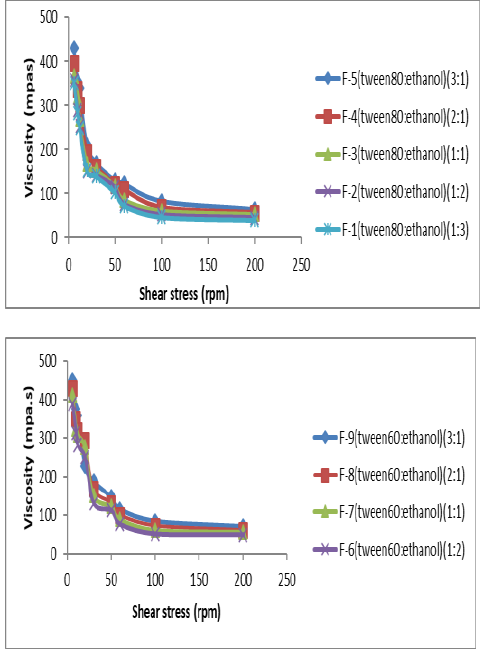
Figure 9. Viscosities of LCDP nanoemulsions